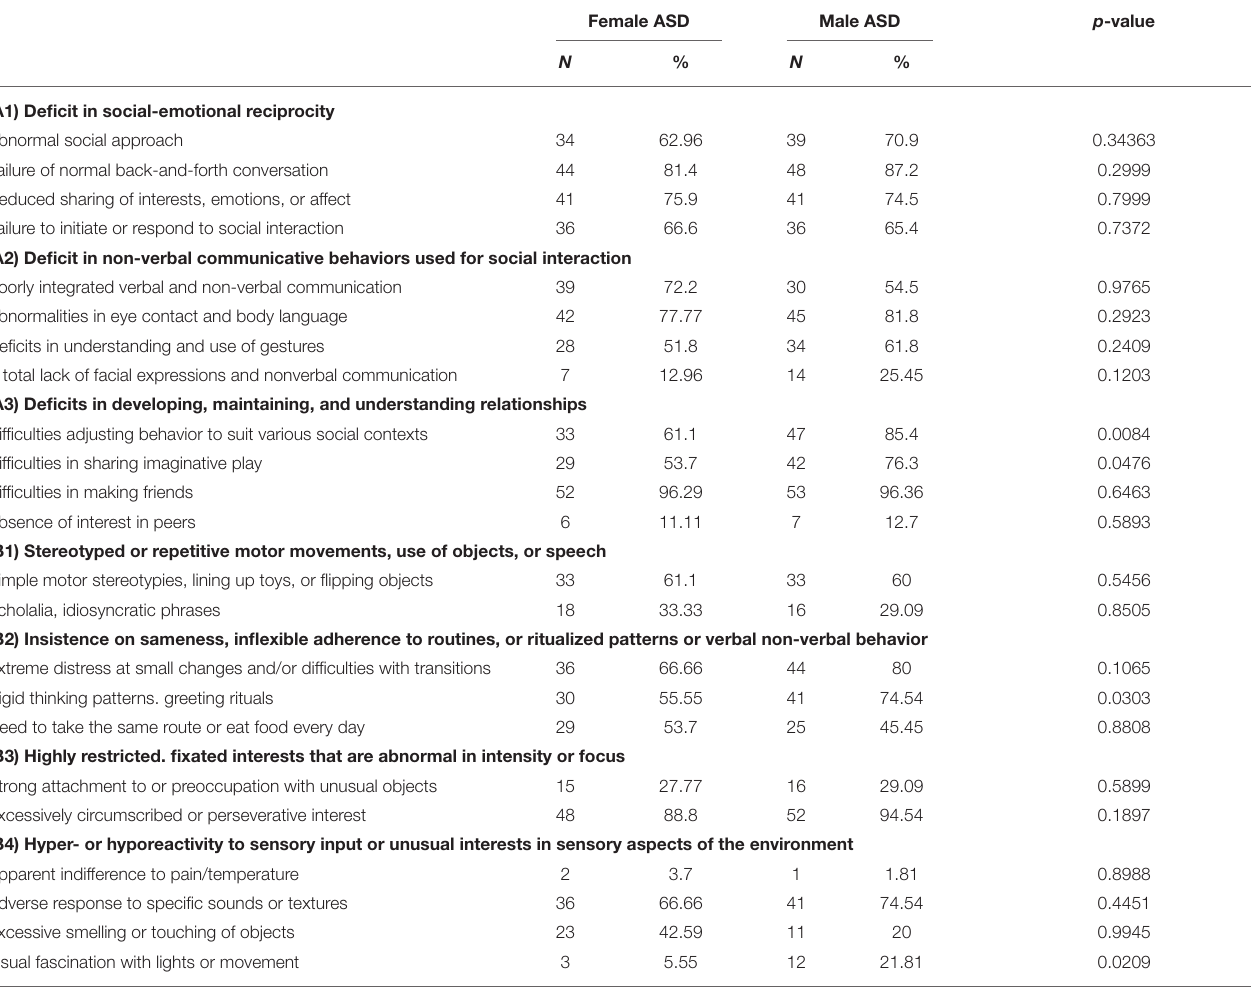
TABLE 3 | Symptoms and signs from DSM-5 diagnostic criteria.